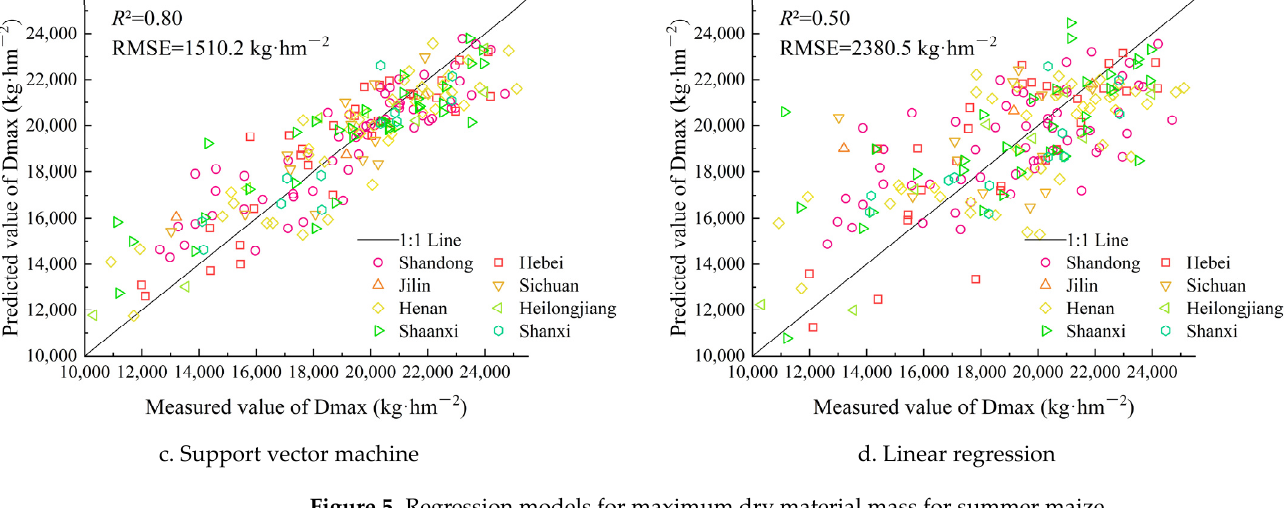
Figure 5. Regression models for maximum dry material mass for summer maize.